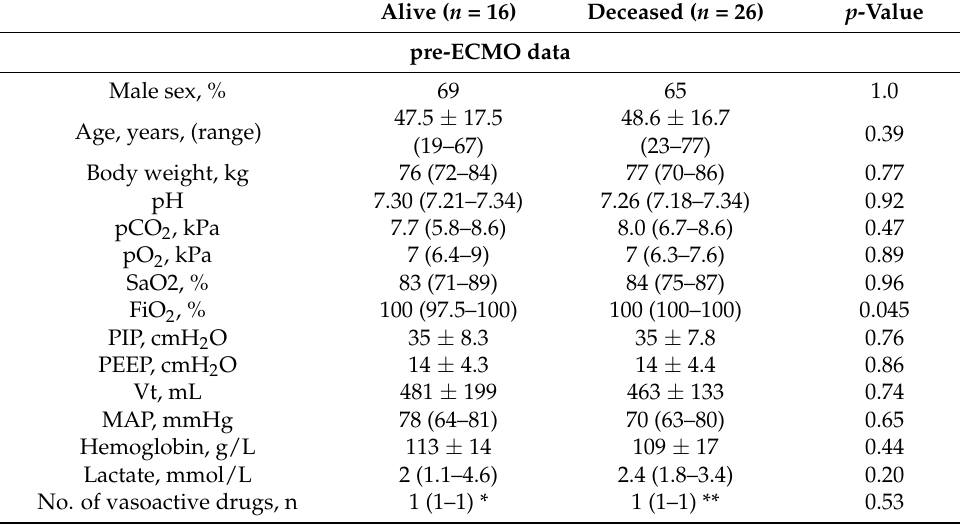
Table 3. Comparison between survivors and deceased. Variables associated with mortality in patients converted from venovenous to venoarterial extracorporeal membrane oxygenation. Data presented as mean ± SD or median (IQR). Differences for variable trajectories within same group: * p = 0.020; ** p = 0.013; # p = 0.007; † p < 0.001. Abbreviations: ECMO: extracorporeal membrane oxygenation; FiO2: fraction inspired oxygen; MAP: mean arterial blood pressure; PEEP: positive end-expiratory pressure, PIP: peak inspiratory pressure; RESP: Respiratory Extracorporeal membrane oxygenation Survival Prediction score; RVF: right ventricular failure; SAPS-3: Simplified Acute Physiology Score; SAVE: Survival After Venoarterial ECMO score; SOFA: Sequential Organ Failure Assessment score; SOFAconv: SOFA score before conversion; SOFAdelta: SOFAconv–SOFAin; SOFAin: SOFA score before ECMO; SOFAc: SOFA score for the circulatory domain; VIS: vasoactive inotropic score (reference [24]); Vt: tidal